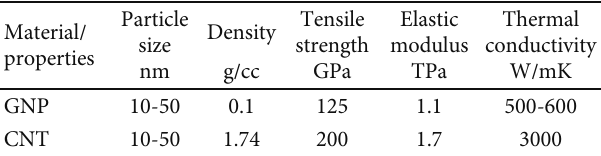
Table 2: Characteristics of GNP and CNT nano fi